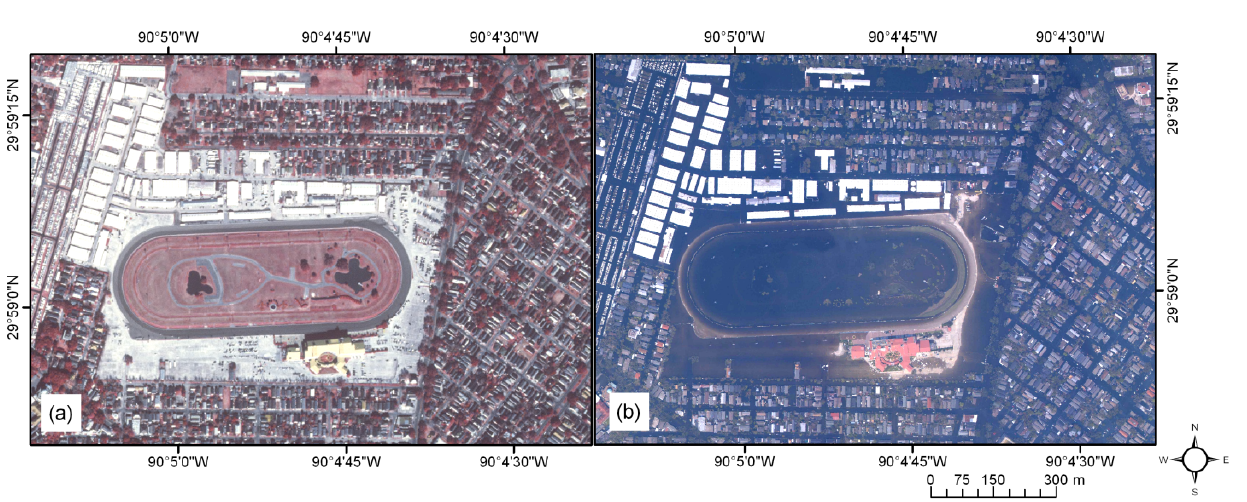
Figure 1. Flooding in New Orleans ( a ) before Katrina, Digital Orthophoto Quarter Quadrangle 2004 image (CIR) and ( b ) after Katrina, National Oceanic and Atmospheric Administration image